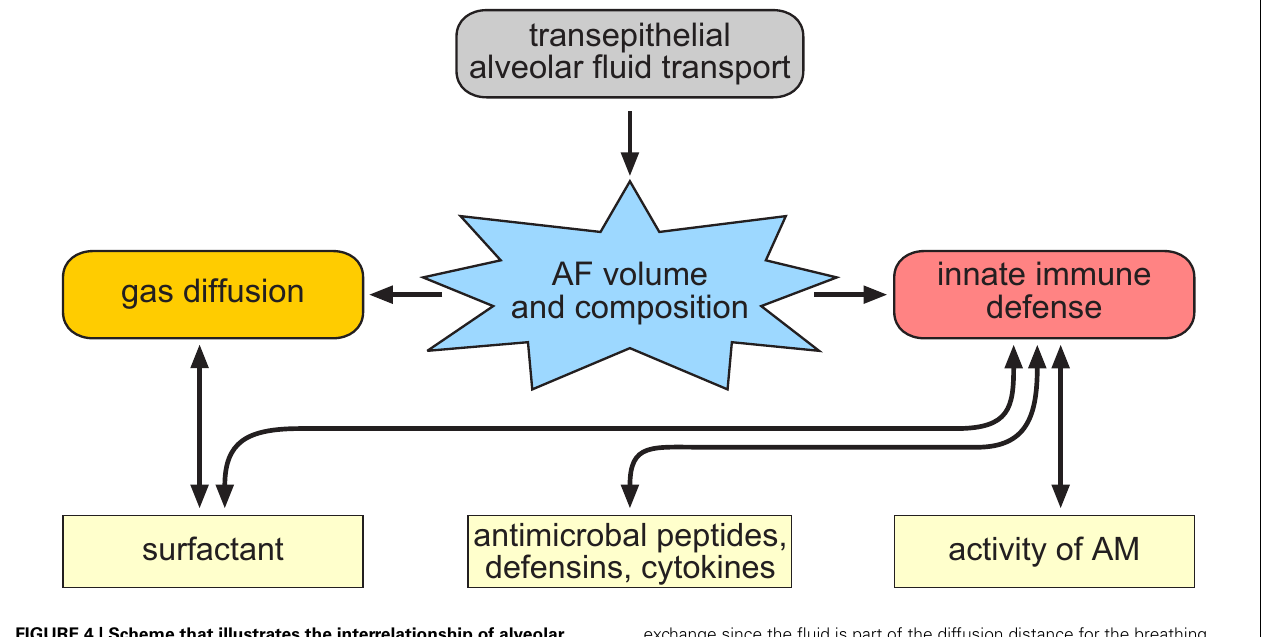
FIGURE 4 | Scheme that illustrates the interrelationship of alveolar fluid transport and the physiological functions related to the composition and volume of the alveolar fluid (AF). The volume and composition of the AF is regulated by transepithelial ion transport processes.The fluid volume and the composition of the AF is a critical factor that influences gas exchange as well as innate immunity responses in the lung.This is due to the fact that the volume of the AF influences gas